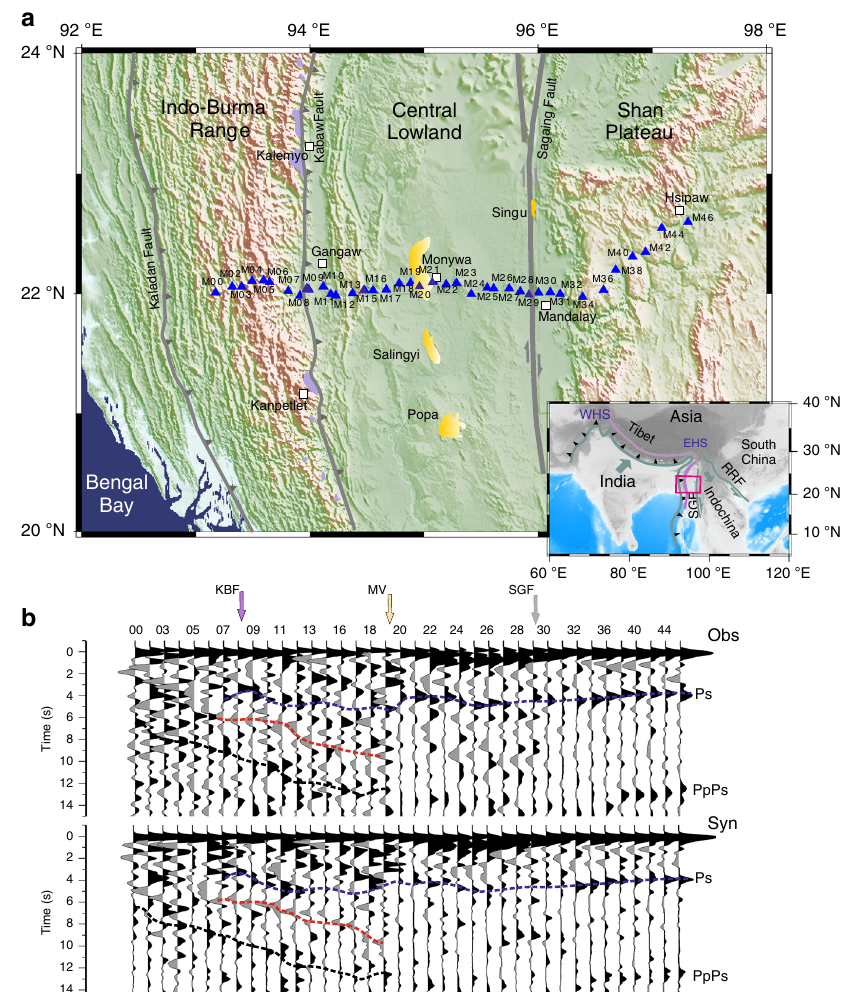
Fig. 1 Topographic map of the study region showing simpli fi ed tectonic divisions, distribution of seismic stations, and cross-sections of P receiver functions. a Map of the convergent system of the Indian and Asian plates in the Myanmar region. Each seismic station used in this study is shown with a blue triangle. The yellow areas mark the outcrops of Late Cretaceous to Miocene volcanic rocks, and the purple areas mark ophiolites in the IBR. The topographic data are derived from the ETOPO1 database 40 . The inset shows the location of the study region in the India – Asia collision system. b Cross- sections (from west to east) of stacked P receiver functions from data (Obs) and synthetic (Syn) images. Traces are plotted in a time window between − 1 and 15 s with time-zero aligning with the onset of the P-wave. The amplitudes of the traces are normalized by the maximum amplitude of all traces. Station numbers are labeled at the top of the plots for ease of reference. Dashed lines indicate the converted phases from the Moho (blue), the top interface (red), and the bottom interface (black) of a dipping structure recognized by waveform inversion. EHS eastern Himalayan syntaxis, WHS western Himalayan syntaxis, KBF Kabaw fault, MV Monywa volcanoes, SGF Sagaing fault, RRF Red River